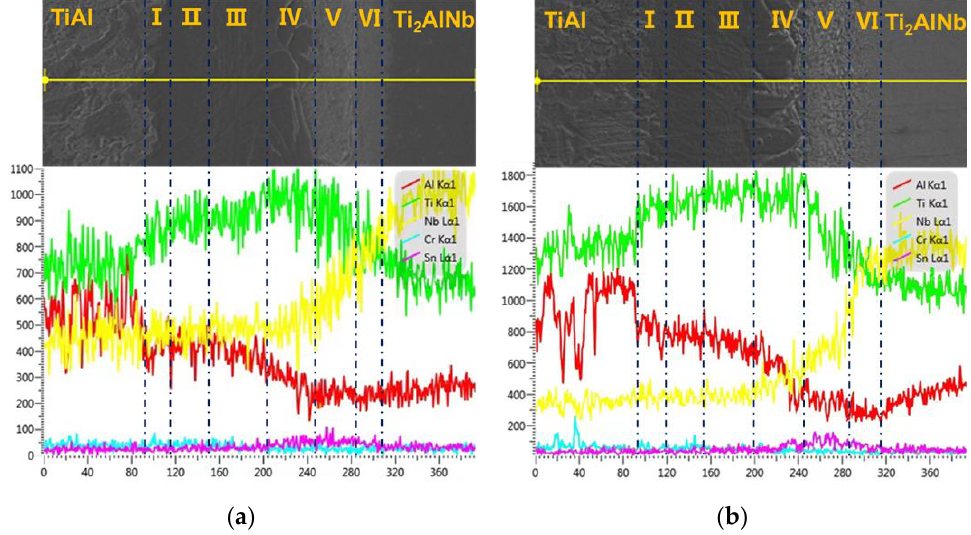
Figure 6. Elements line scan results of the joint. ( a ) As-welded joint; ( b ) PWHT joint.